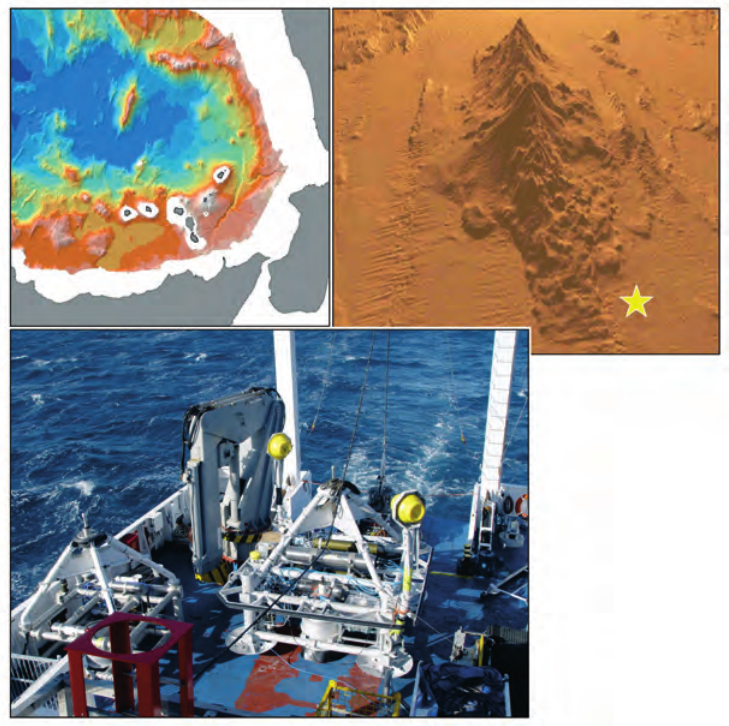
Fig. 11. Swath bathymetry of the Southern Tyrrhenian Sea, on the right a 3D picture viewed from the north of the Marsili underwater volcanic seamount (Central Tyrrhenian bathyal plain) (Marani et al. , 2004). The yellow star indicates the site of the ORION-GEOSTAR-3 experiment at the NW base of the seamount (over 3300 m w.d.). Photographs of GEOSTAR ( right ) and Node 3 ( left ) are shown at the bottom of the